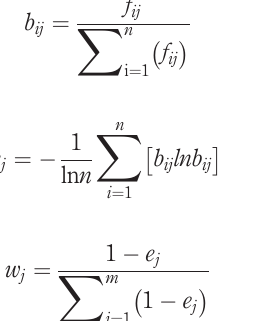
is the entropy of the j -th indicator and w j